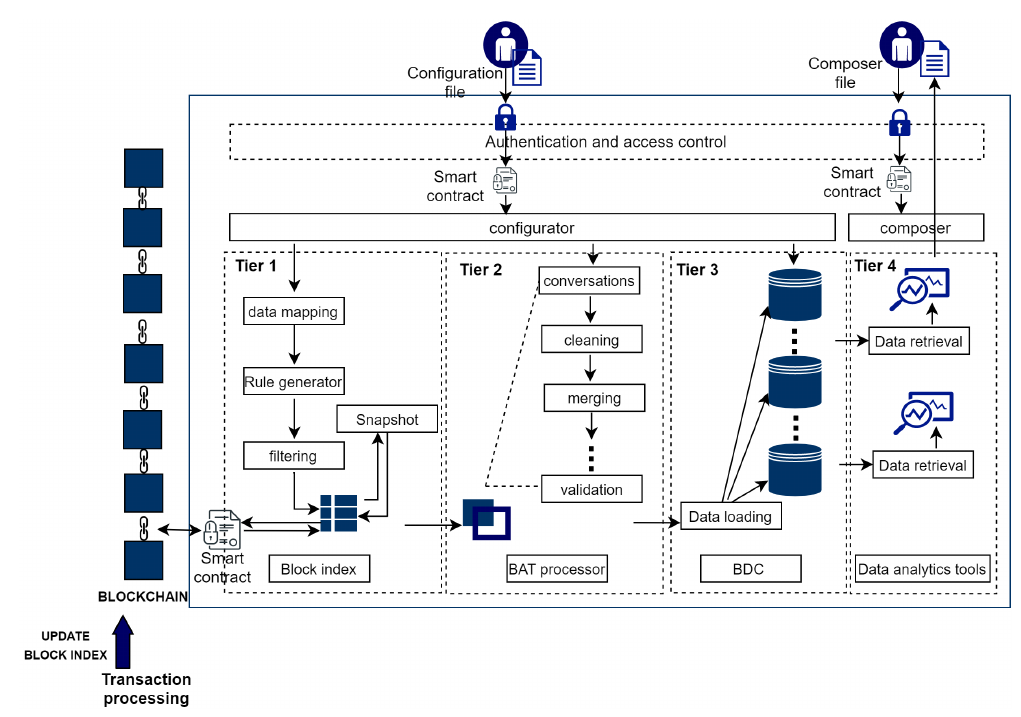
Figure 4. Overview of the Block Analytics Tool (BAT) integrated with